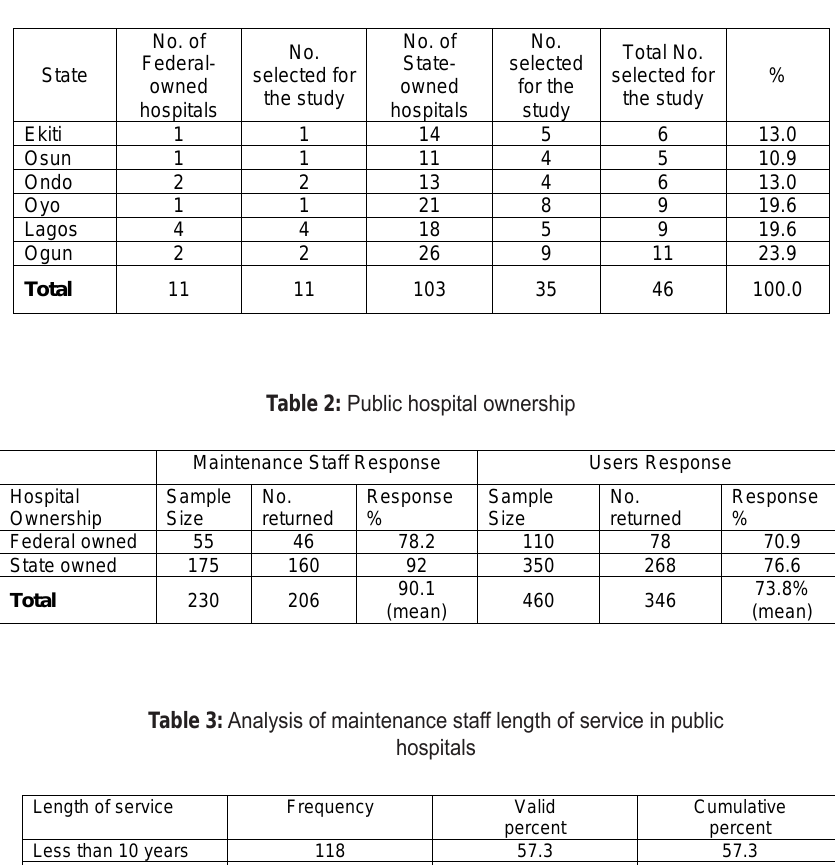
Table 1: Sample frame for Federal and State-owned hospitals